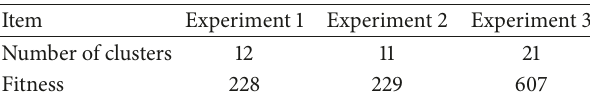
Table 2: Results of DE based clustering